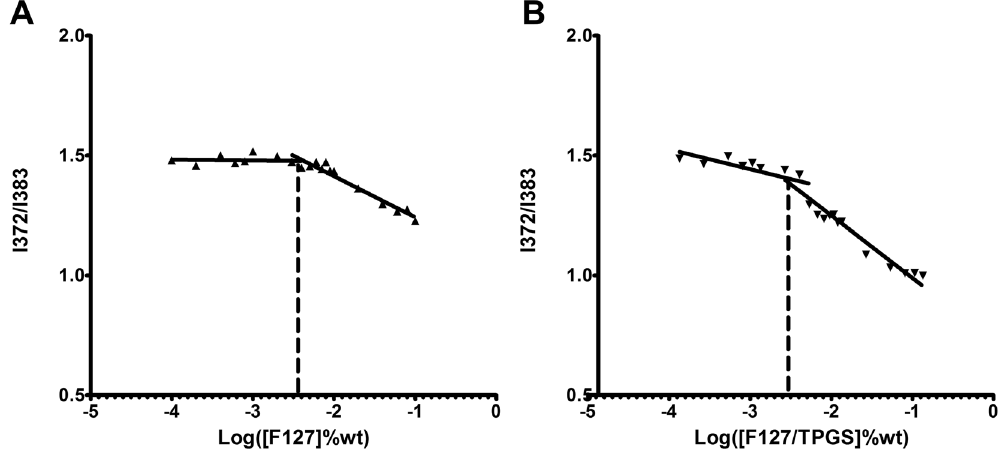
Figure 2. Plot of I372/I383 versus concentrations of copolymers in deionized water. Copolymers of F127 ( A ); F127/TPGS (4:1) ( B